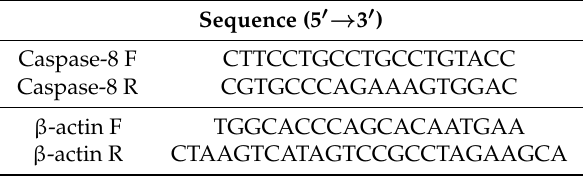
Table 1. Primer sequences used for quantitative reverse transcription polymerase chain reaction